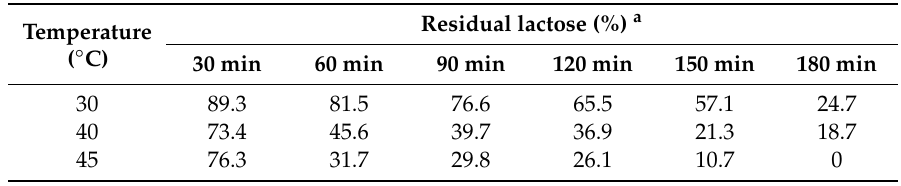
Table 2. E ff ect of temperature on the progress of lactose hydrolysis in whey permeate by